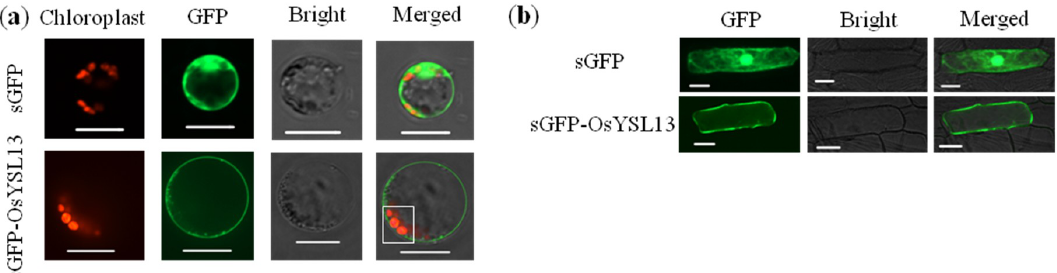
Figure 2. Subcellular localization of OsYSL13 . ( a , b ) Subcellular localization of OsYSL13 in the rice leaf protoplasts ( a ) and onion epidermal cells ( b ). sGFP-OsYSL13 construct was transiently transformed into the rice leaf protoplasts and onion epidermal cells. Fluorescent signals were observed 16 h after transformation. The red autofluorescence represents the location of the chloroplasts, and the green signal indicates the position of GFP or GFP-OsYSL13 fusion protein. The white box shows the relative position of GFP-OsYSL13 fusion protein and chloroplast. Scale bars = 15 and 60 μm in a and b , respectively.